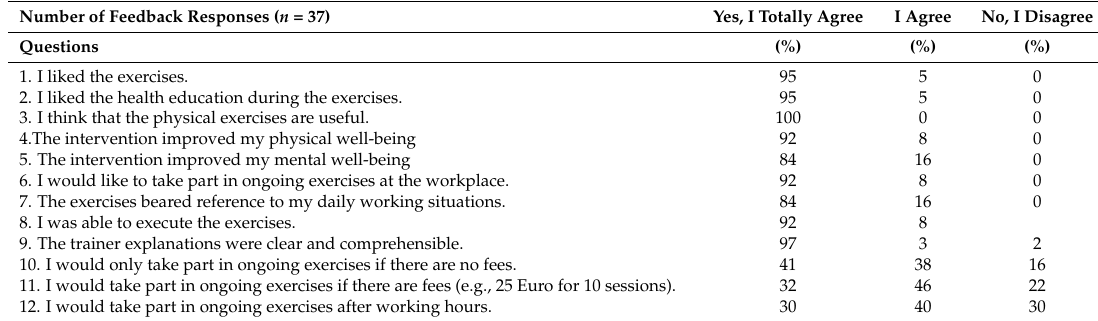
Table 6. Feedback after additional exercise at the workplace (10